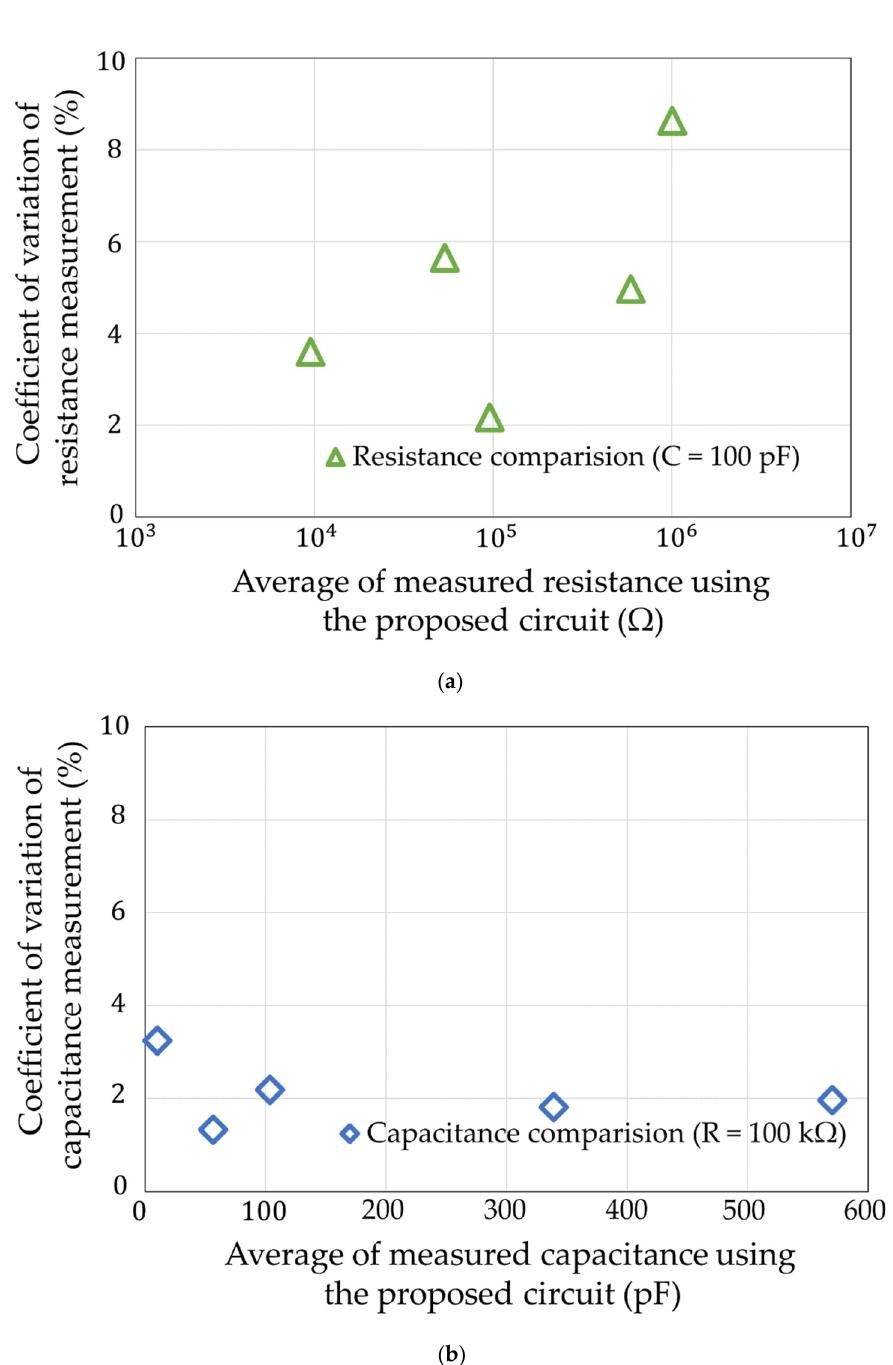
Figure 14. Deviation of the measurements with the impedance analyzer. ( a ) About resistance. ( b ) About capacitance.